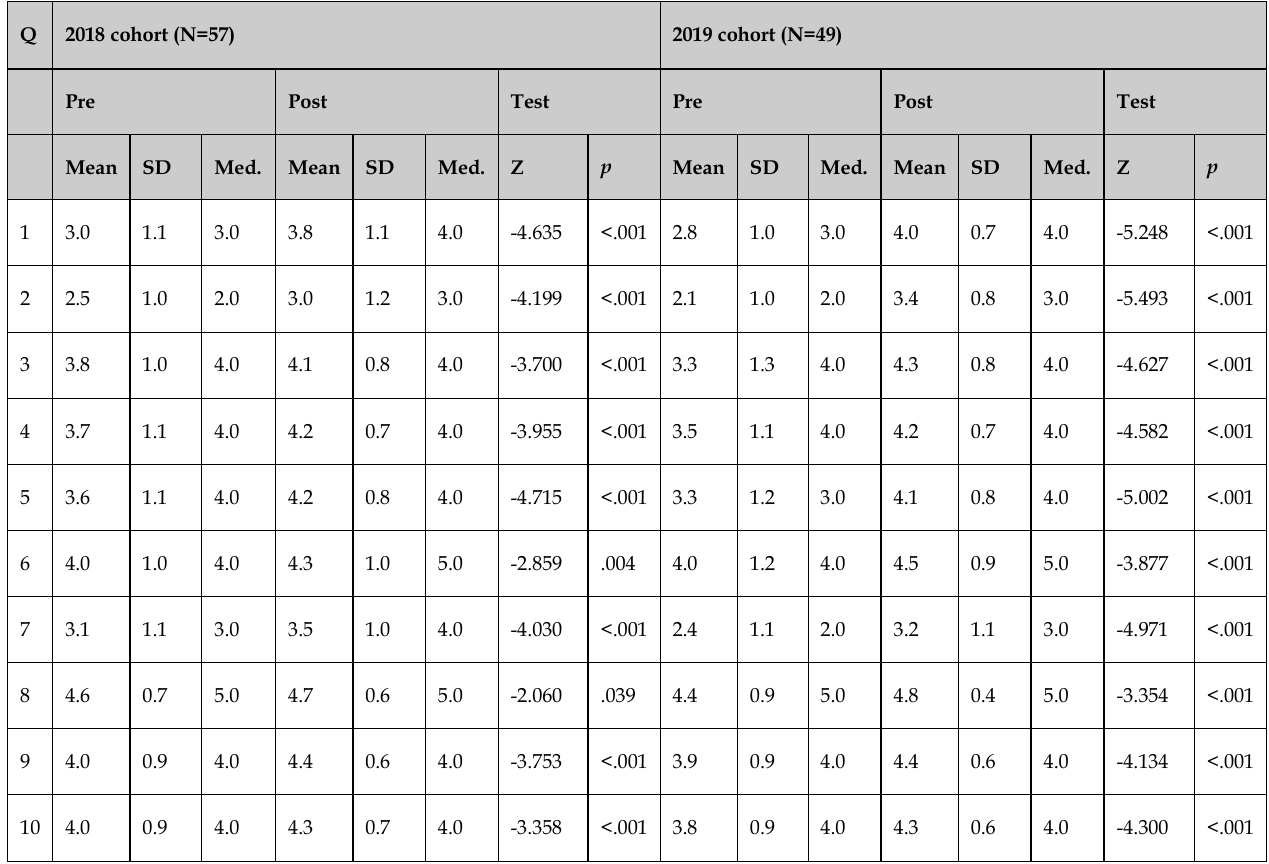
Table 2 Information literacy